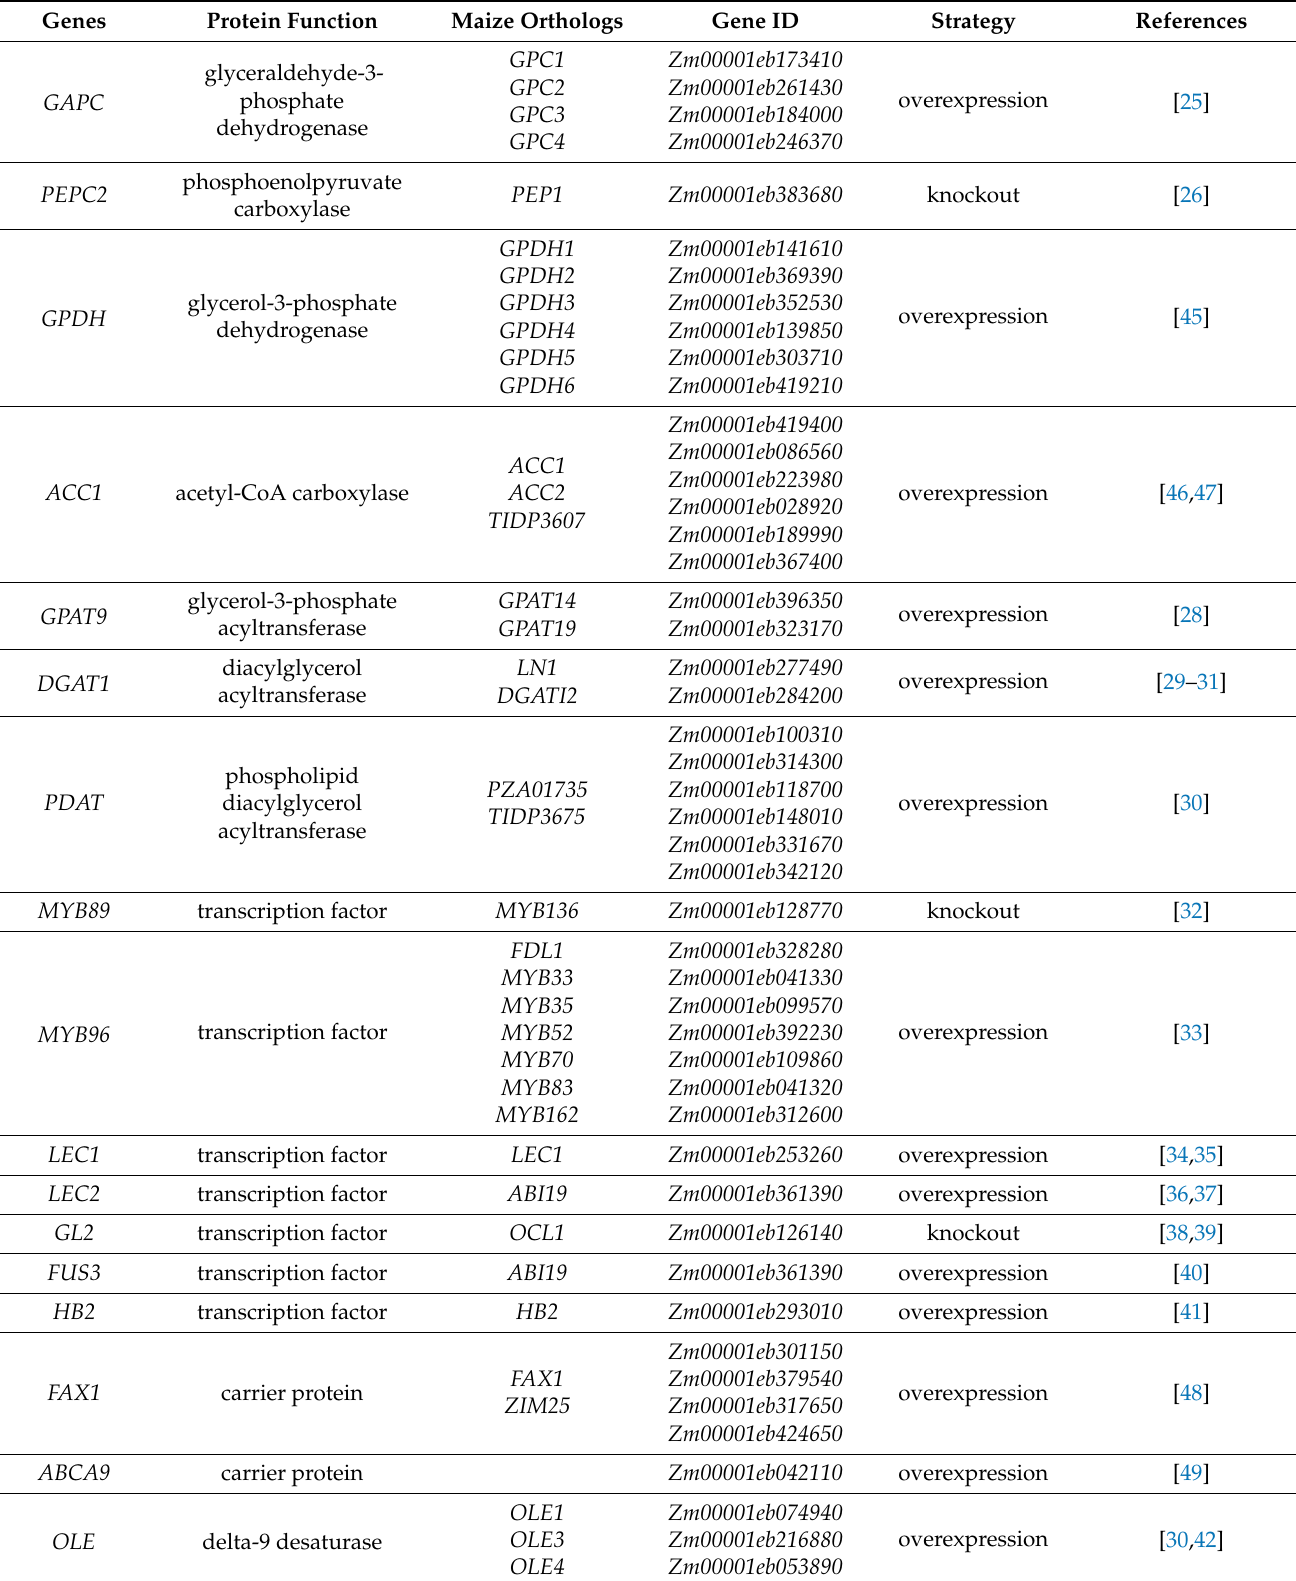
Table 2. List of potential gene resources for enhancing lipid yield in